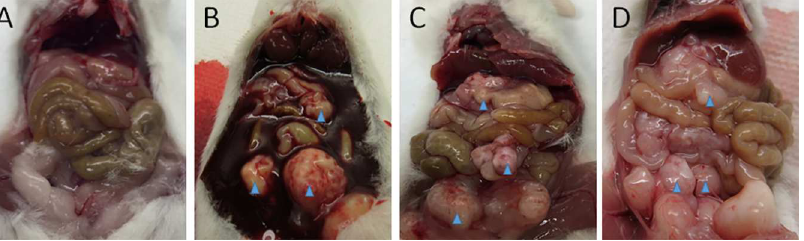
Fig 1. Formation of peritoneal tumor nodules and bloody ascites in SCID mice after intraperitoneal injection of 5X10 6 cells. (A) No peritonealtumor formation was observed even 4 months (120 days) after intraperitoneal injectionof OACM5.1C cells. (B) Multiple peritonealtumor formation with bloodyascites was observed~55 days after intraperitoneal injectionof OE19 cells. (C) Multipleperitonealtumor formation but no bloodyascites was observedin OE33 cells ~65 days after intraperitoneal injection. (D) Similarly in SK-GT-2 cells multiple peritoneal tumor formation without bloody ascites was observed~76 days after intraperitoneal injection. Blue arrows show the